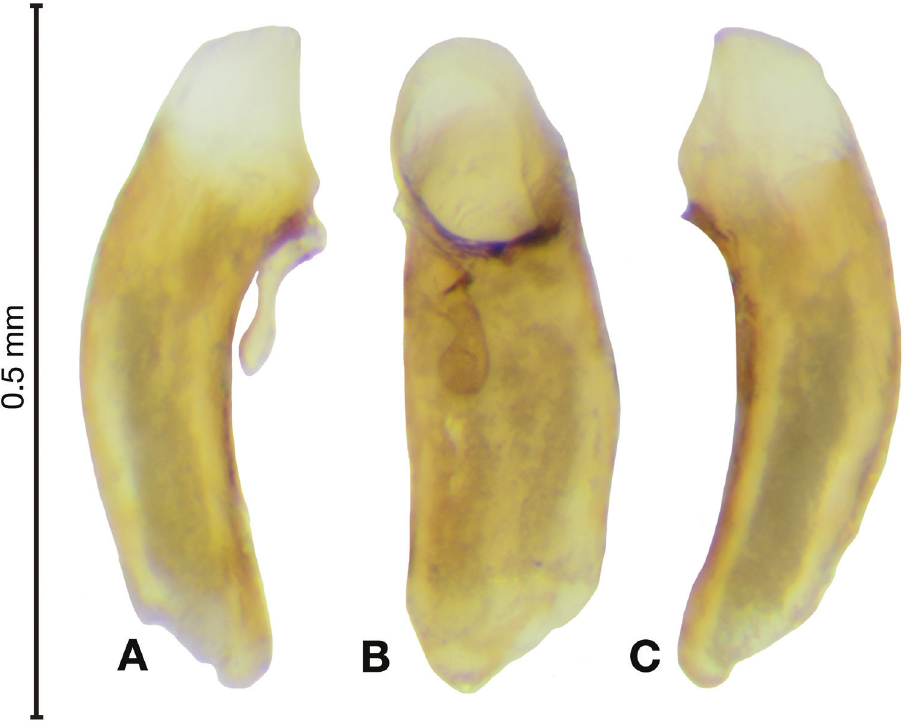
Figure 14. Digital images of male genitalia of Bellavalentis kuzugamii (Shibata). A right lateral aspect B ventral aspect C left lateral